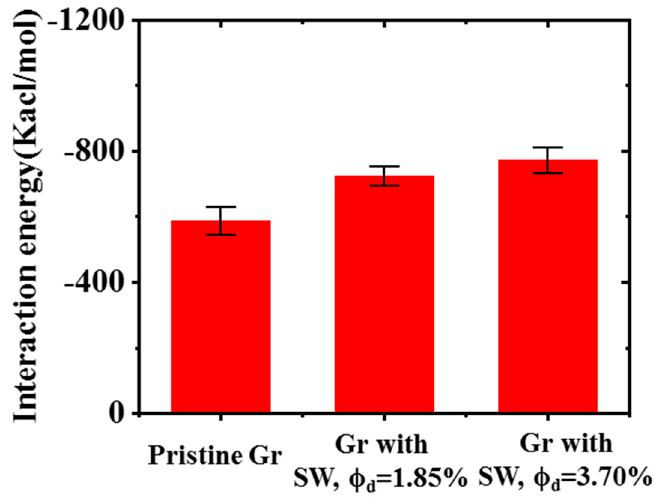
Figure 10. The interaction energy of Gr/epoxy with different concentrations of SW defect.